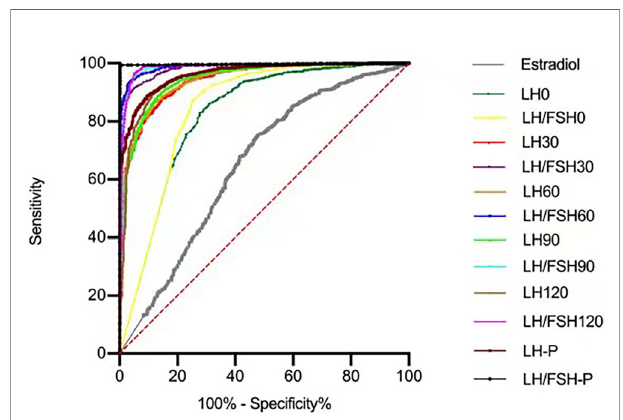
FIGURE 2 | ROC curves used to evaluate the sensitivity and speci fi city at each level for LH and LH/FSH post GnRH